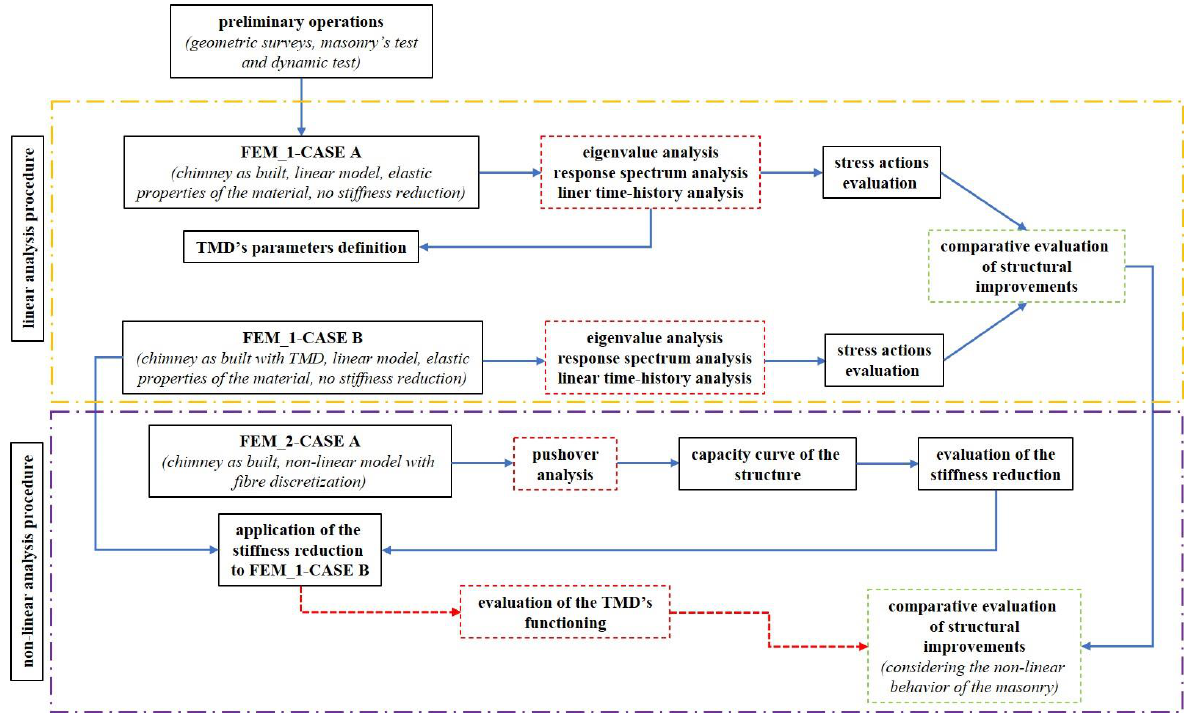
Figure 6. Flow diagram of the proposed optimization procedure.